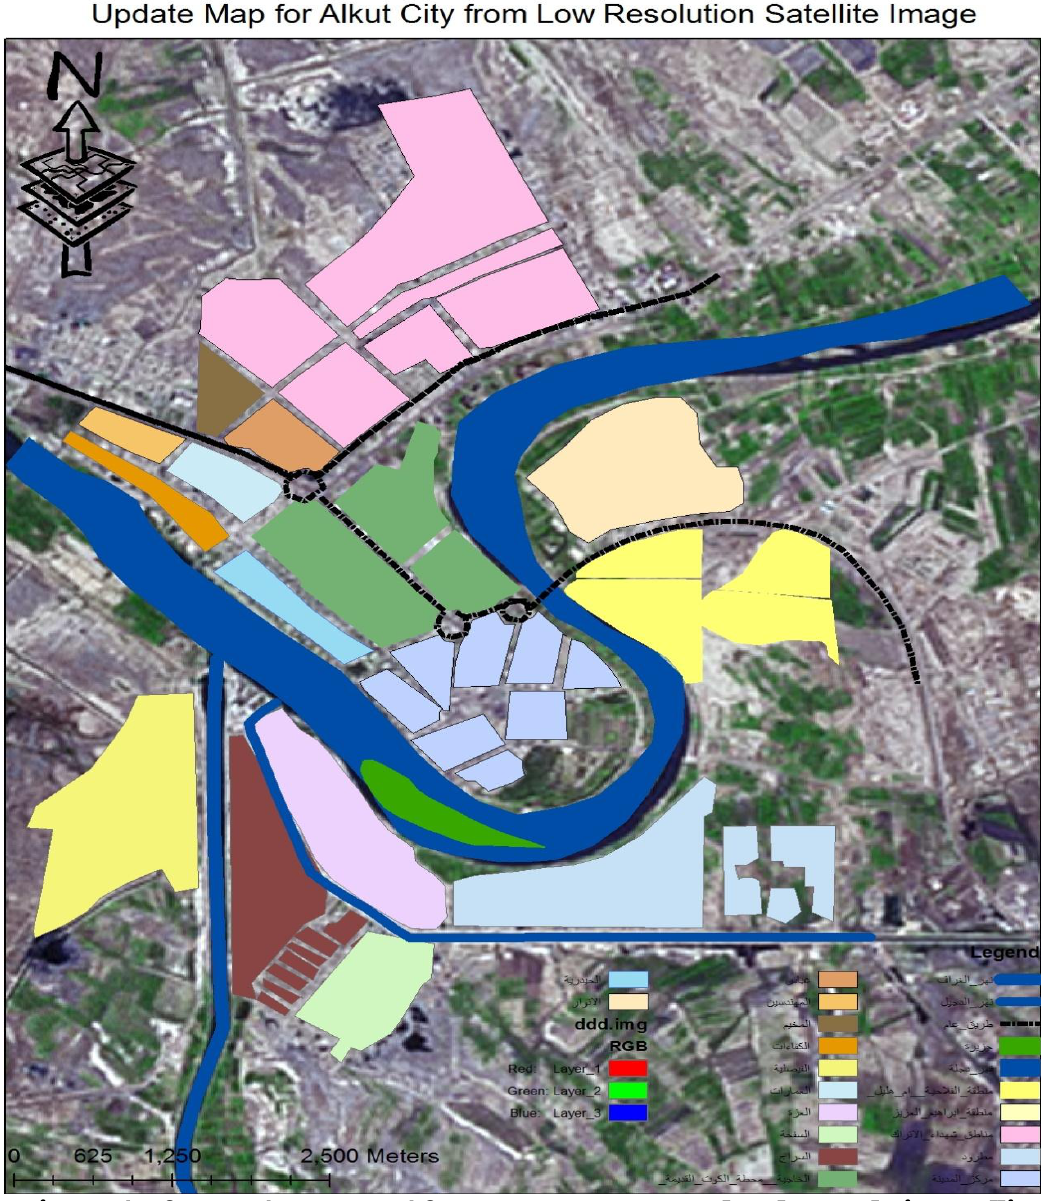
Fig.23: The features that extracted from map at 1:100,000 scale & low resolution satellite